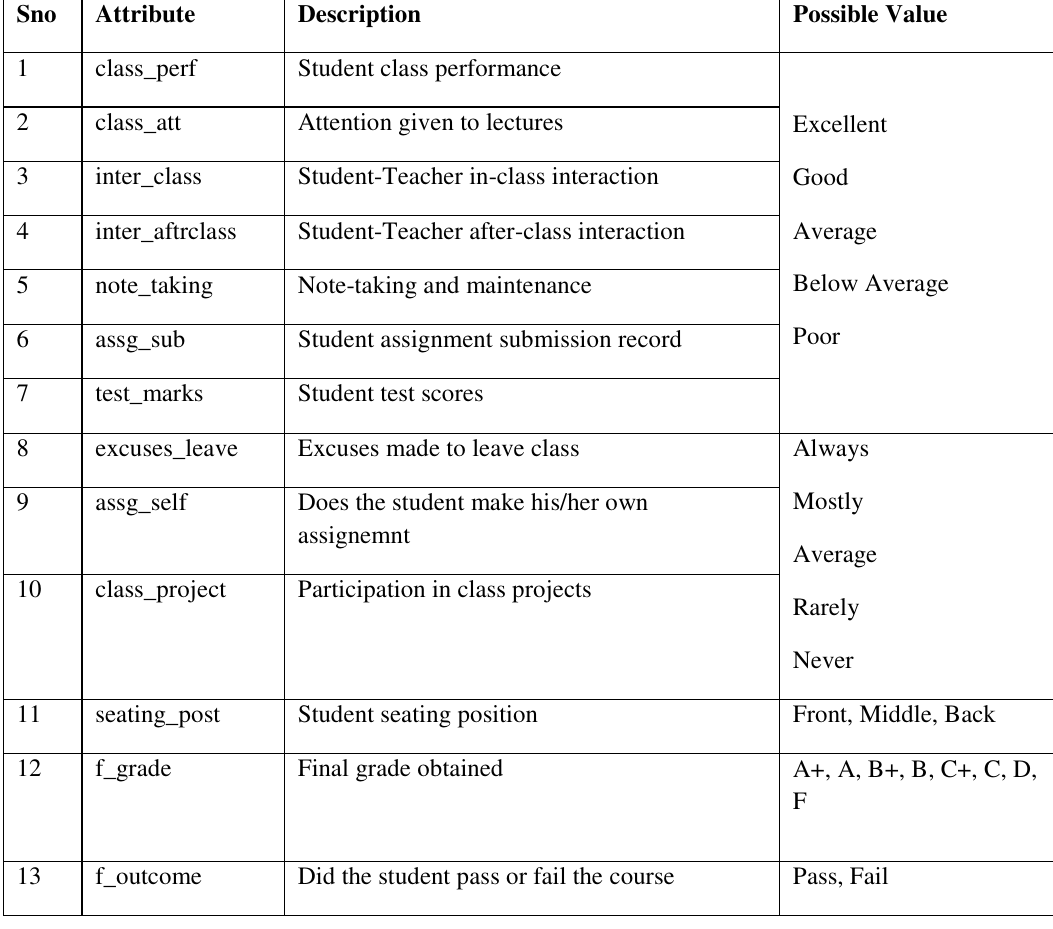
Table 2 Student attributes and their possible